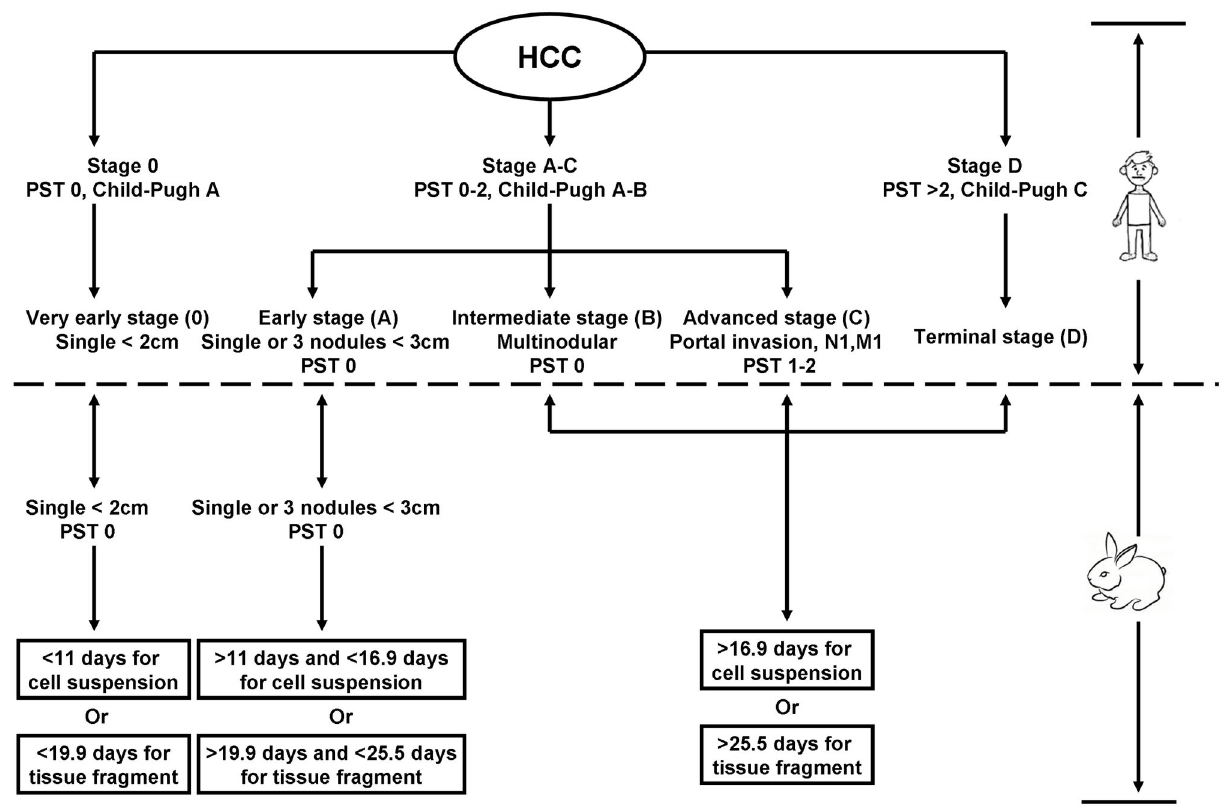
Figure 6. Comparisons of the VX2 staging with the BCLC staging. PST=Performance Status Test; N=lymph node;